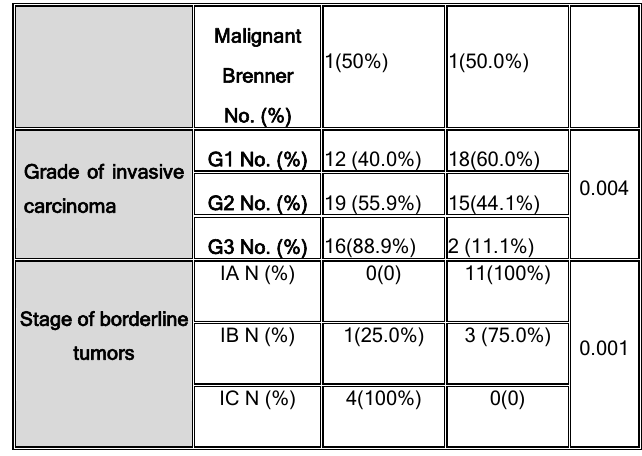
Figure 1 Pie charts showing distribution of ovarian carcinoma cases (left) and borderline tumors (Right) according to FIGO staging system.